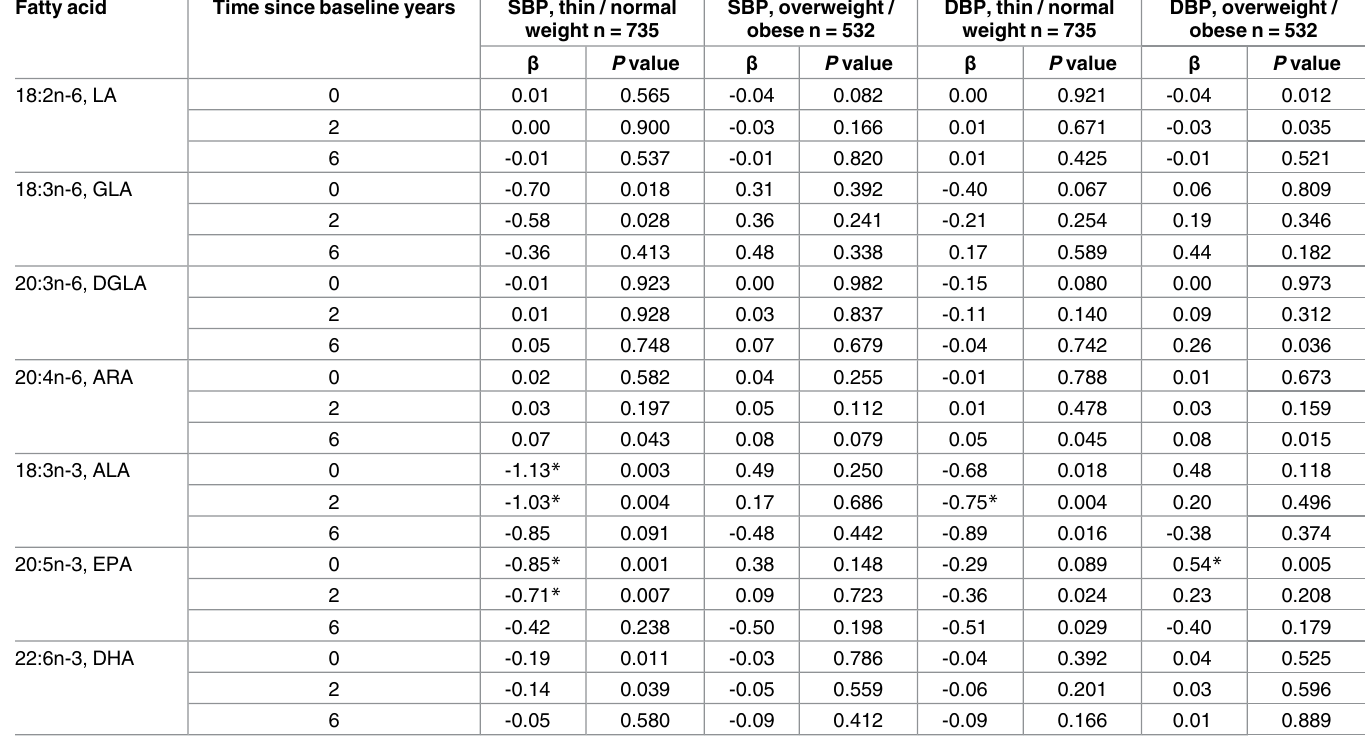
Table 3. Associations of fatty acids with systolic and diastolic blood pressure z-scores at baseline, after two years and after six years of follow- up stratified by BMI category 1 . Fatty acid